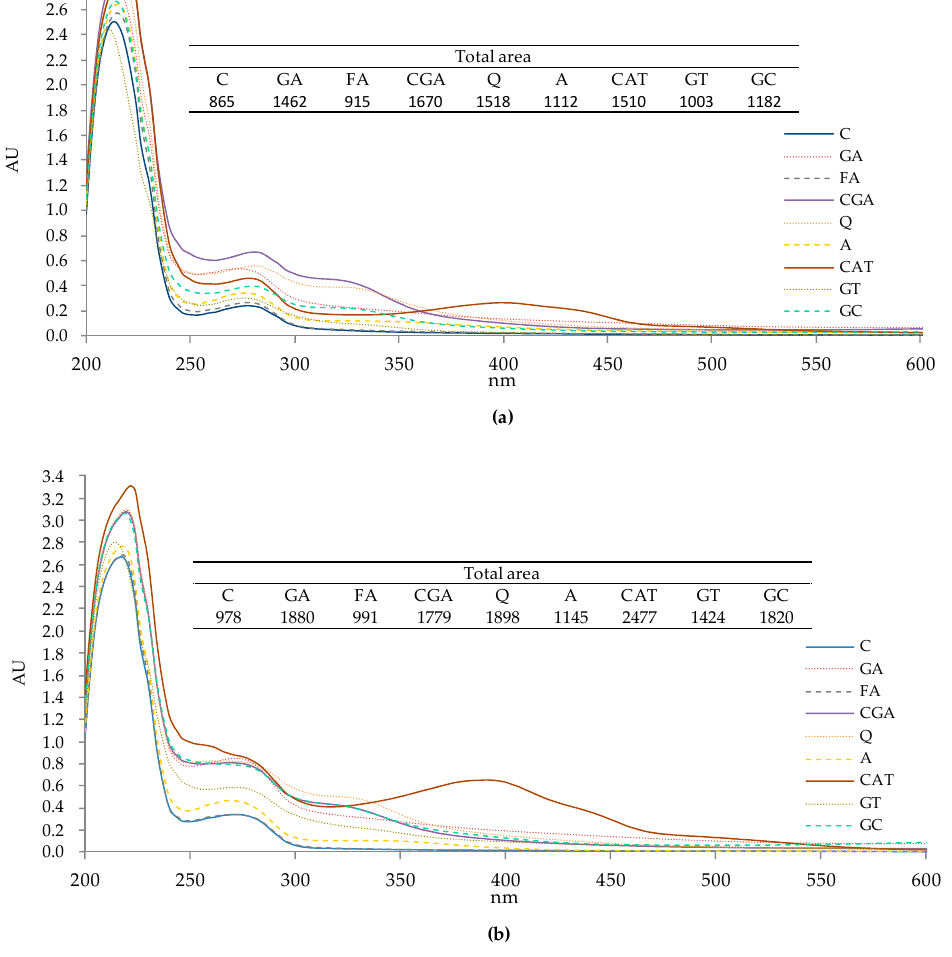
Figure 1. UV-Vis spectra of protein–phenolic complexes. ( a ) albumins; ( b ) globulins. C–control sample, GA, FA, CGA, Q, A, CAT, GT, GC–protein samples after incubation with gallic acid, ferulic acid, chlorogenic acid, quercetin, apigenin, catechin, green tea, and green coffee extracts, respectively.